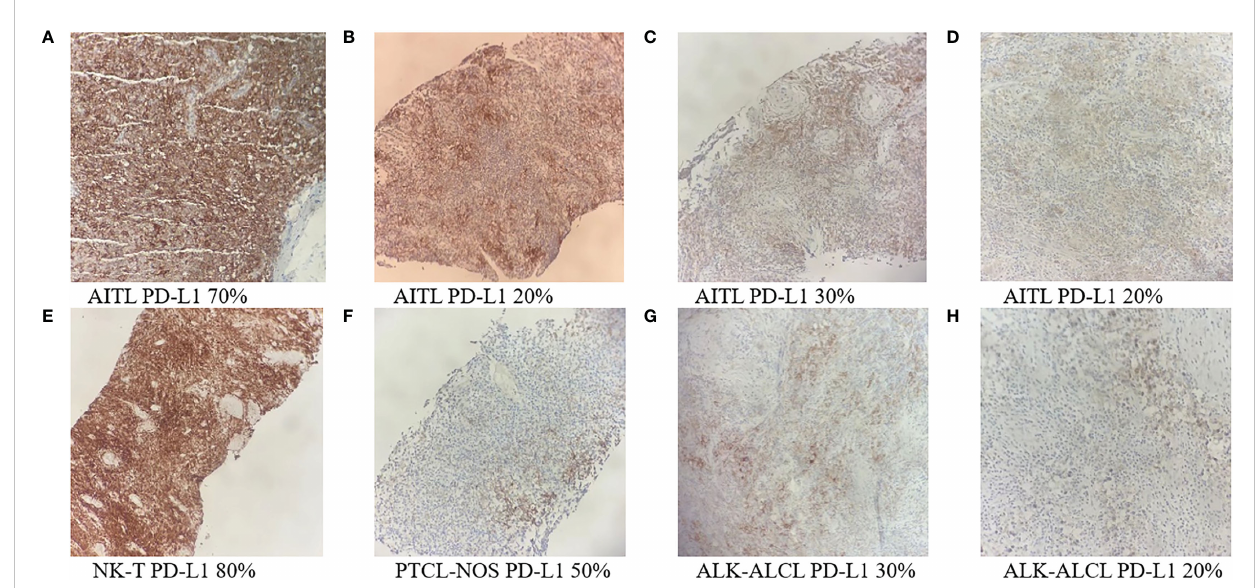
FIGURE 4 PD-L1 immunohistochemistry staining of tumor biopsy samples from eight PTCL patients (A-H) (Original magni fi cation ×100). AITL, angioimmunoblastic T-cell lymphoma; ALK-ALCL, ALK negative anaplastic large cell lymphoma; ENKTL, extra nodal natural killer/T-cell lymphoma; PTCL-NOS, peripheral T-cell lymphoma, not otherwise speci fi